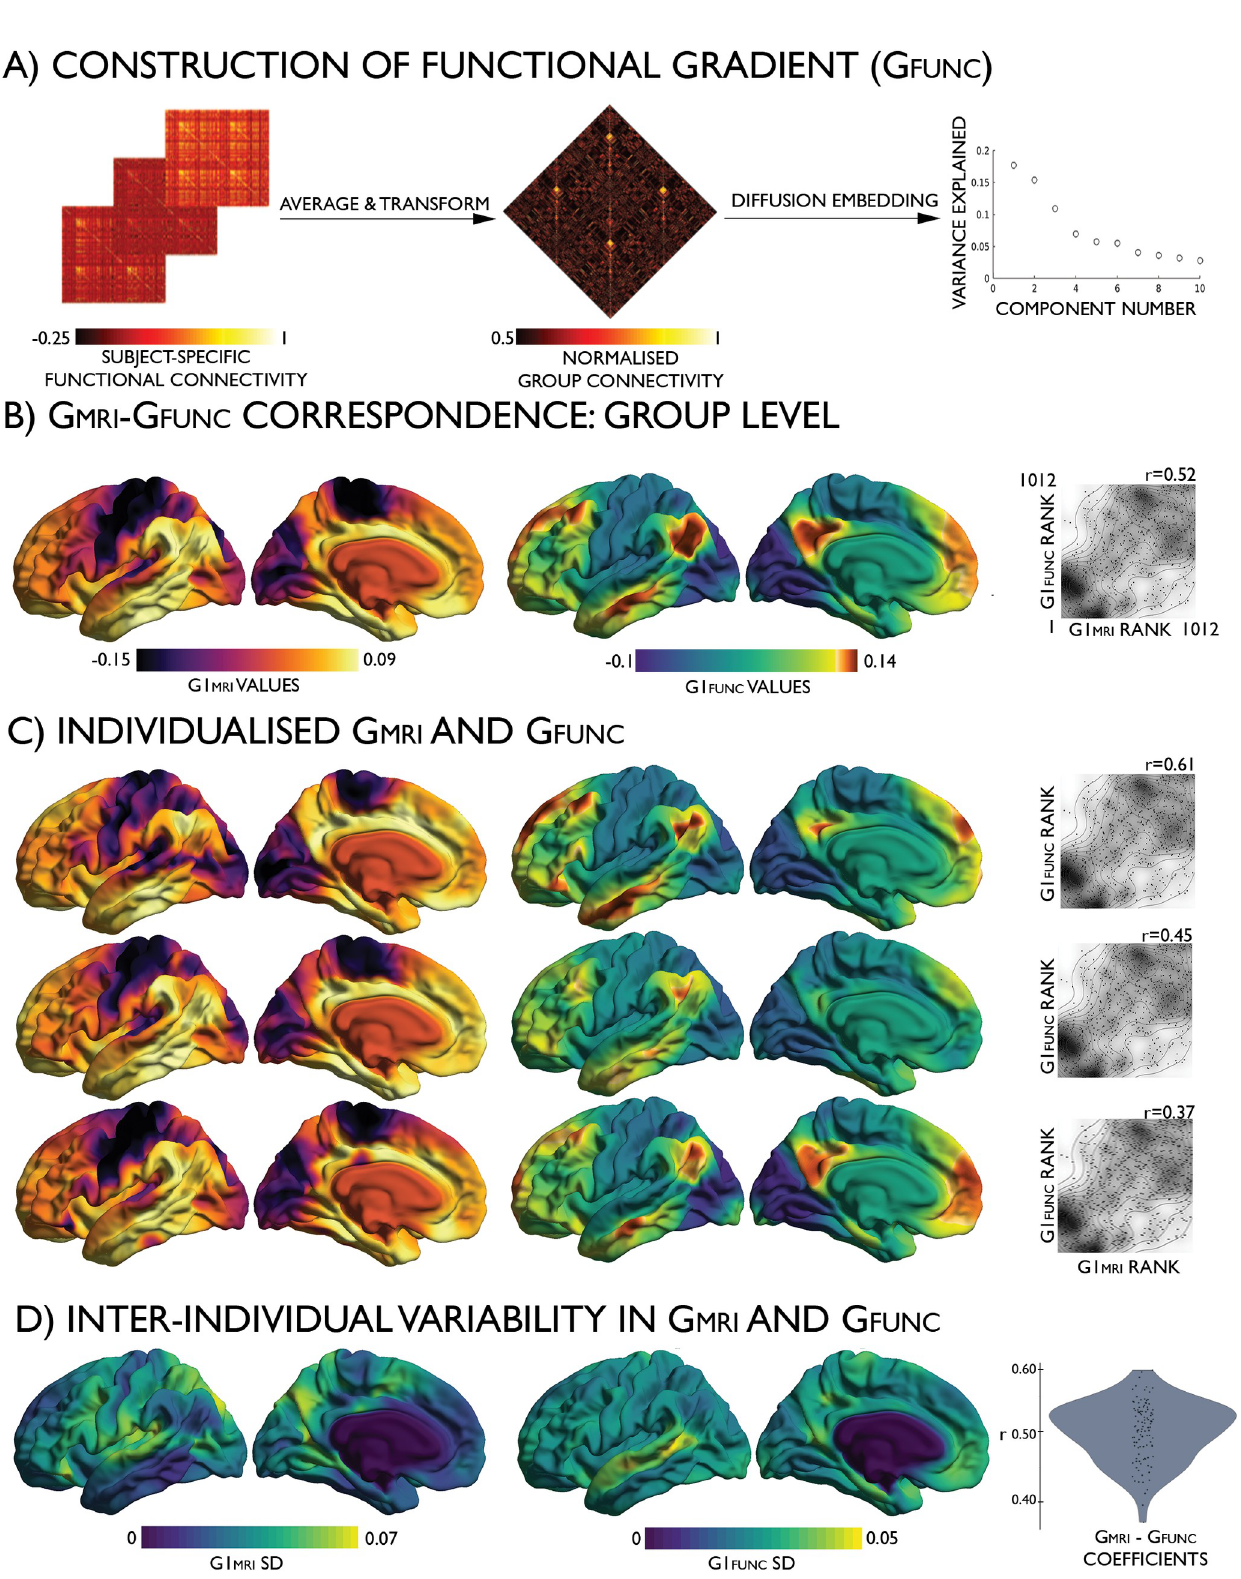
Fig 4. Cross-modal correspondence of the MPC MRI and intrinsic functional gradients. (A) Transformation from individual functional connectomes (left) to a group average normalised angle matrix (centre) to diffusion-embedding components (right). (B) The group-level G1 MRI (left), group-level G1 FUNC